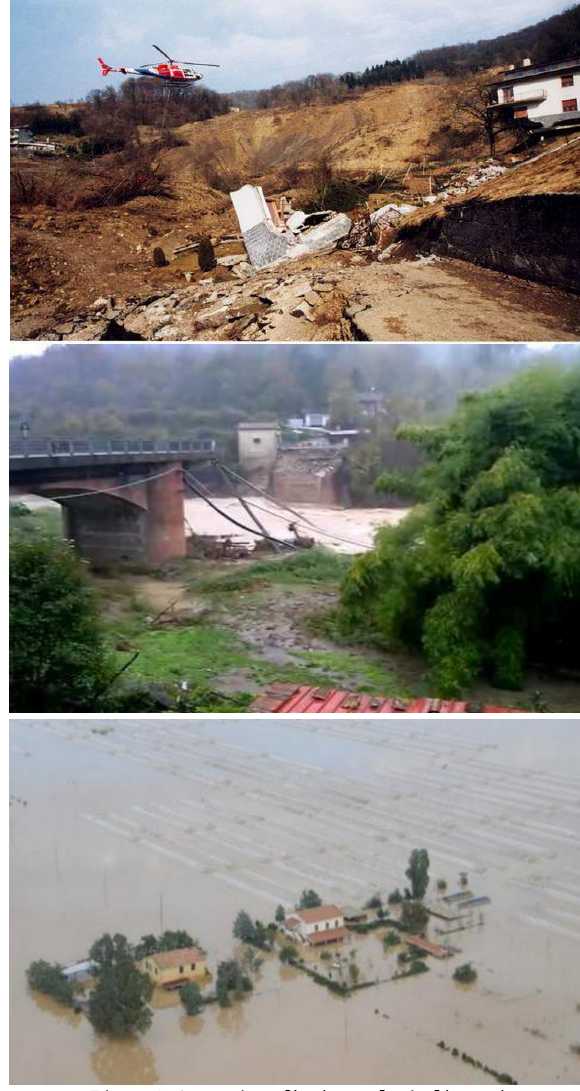
Figure 1. Scenarios of hydrogeological hazard The areas showing a high hazard can be identified even thanks to thermic and pluviometric data and to the inventory of collapsing structures.